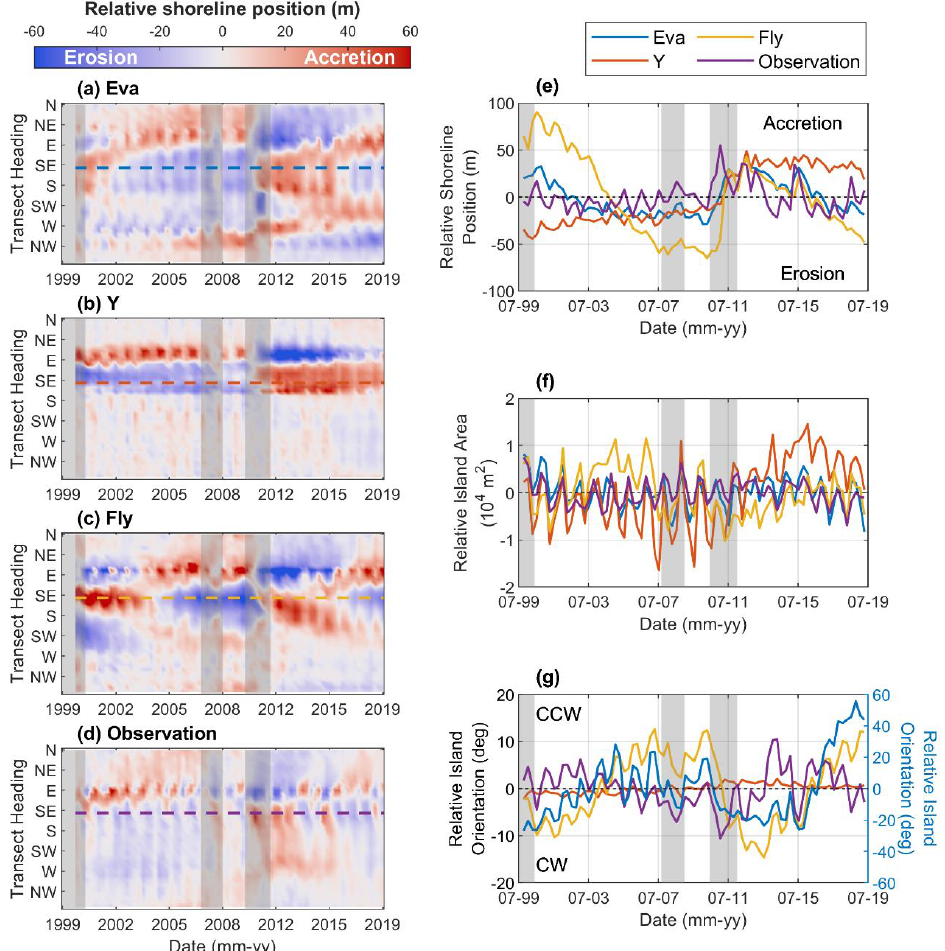
Figure 6. ( a – d ) Seasonally averaged shoreline position (referenced to the 20 year mean shoreline position) at ( a ) Eva, ( b ) Y, ( c ) Fly, and ( d ) Observation islands. Blue denotes erosion and red denotes accretion. ( e – g ) Seasonally averaged ( e ) shoreline position at a representative transect from the southeastern (~140° from north, dashed line in panels a – d ) side, where positive indicates accretion and negative indicates erosion, ( f ) island area (relative to 20 year average area), and orientation (relative to 20 year average orientation), where positive denotes counter-clockwise (CCW) rotation and negative denotes clockwise (CW) rotation. As the rotation of Eva Island was greater than others, there is a right-hand axis for Eva Island (blue) and a left-hand axis for Y, Fly, and Observation islands. The 140° transect was used, as it is indicative of shoreline changes across all four islands. In panels ( e – g ), the blue line represents Eva Island, the orange line is Y Island, the yellow line is Fly Island, and the purple is Observation Island. In all panels, grey shading denotes La Niña events, classified as periods when MEI is less than −1.